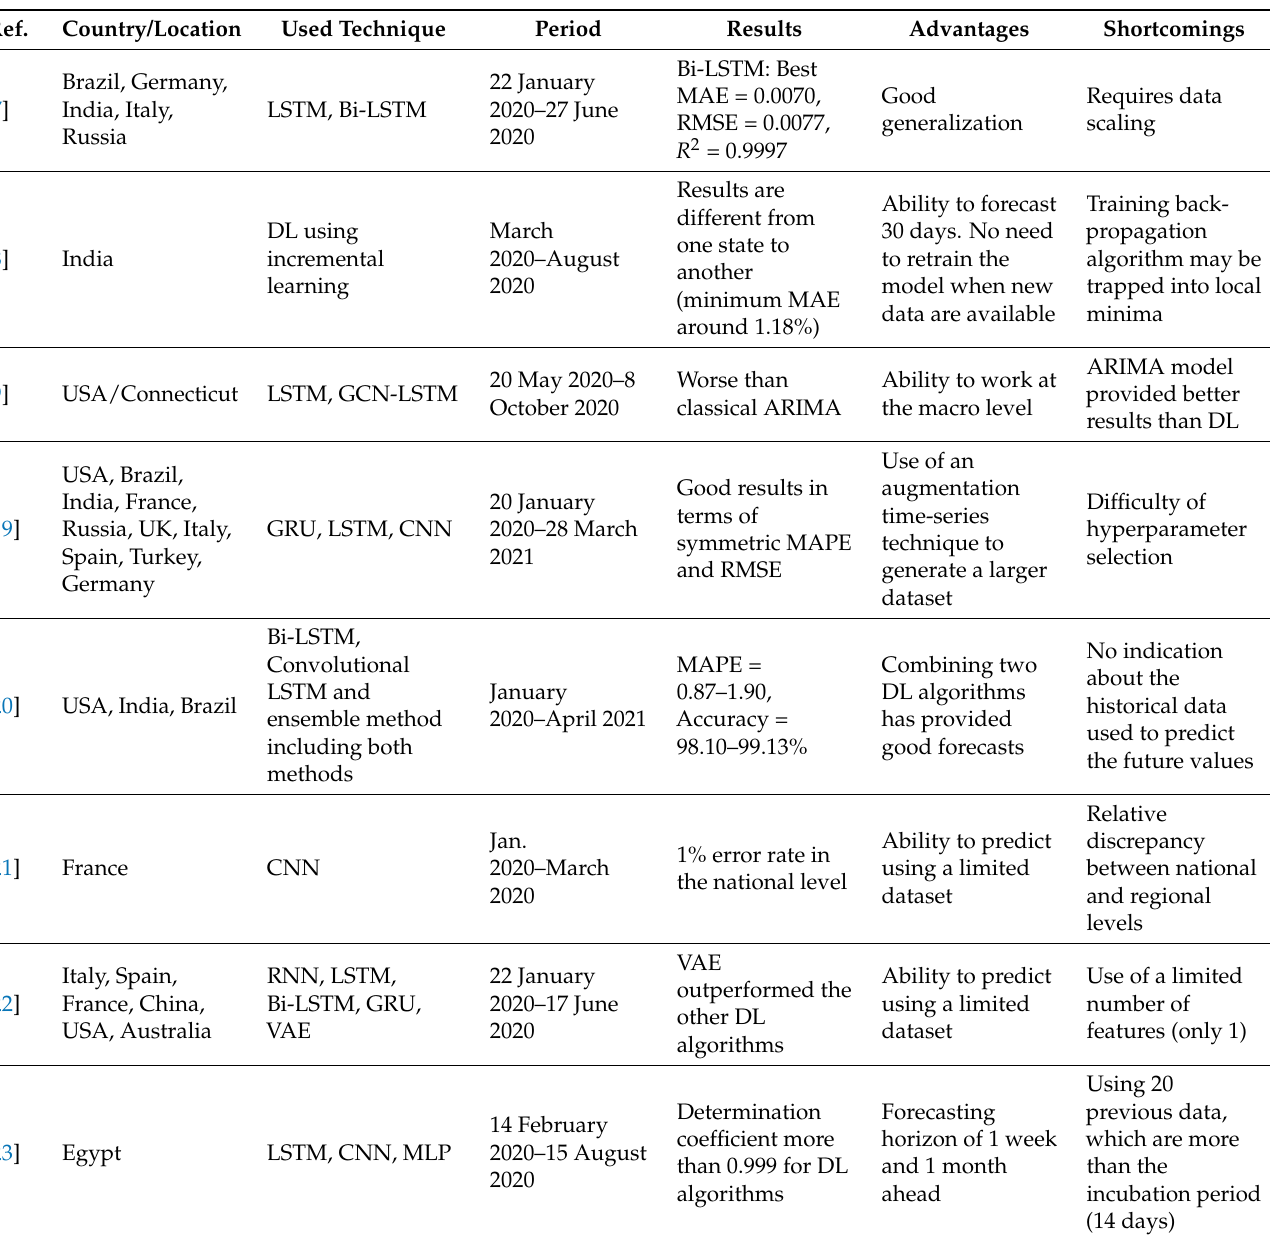
Table 1. Summary of selected studies using DL and model-based methods for modeling/predicting COVID-19 spread